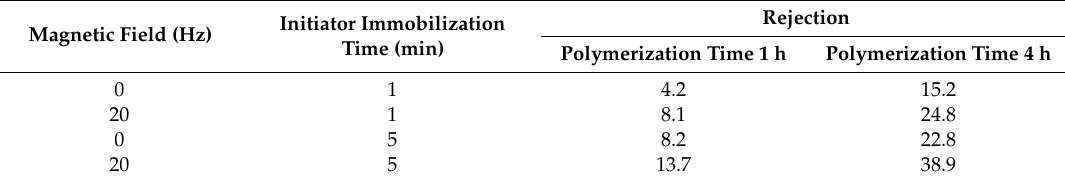
Table 6. Dextran rejection (%) by modified